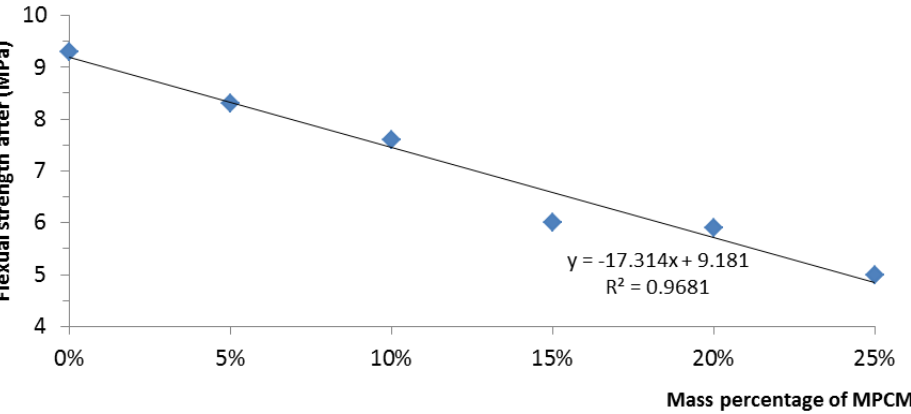
Figure 18. Relationship between the flexural strength and mass percentage of